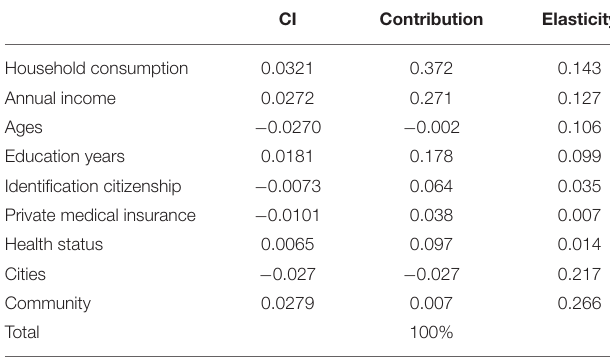
TABLE 4 | Decomposition of health education